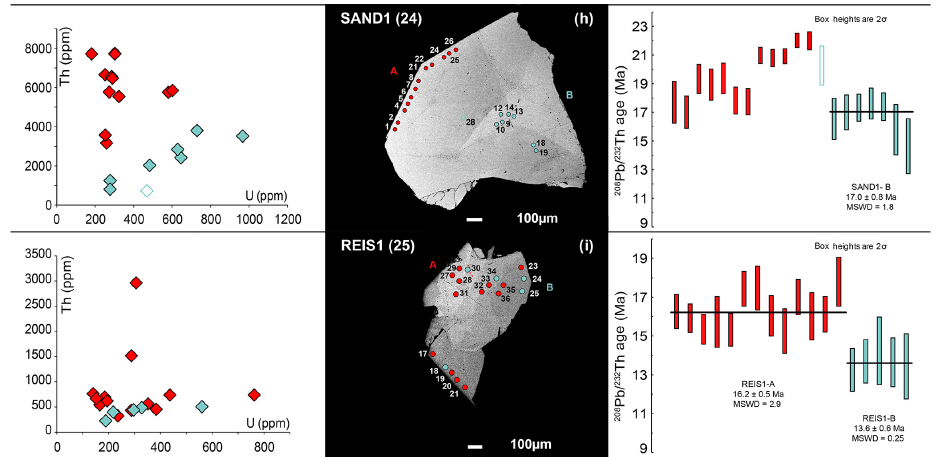
Figure 5. Chemical, textural and geochronological information of monazite grains from the eastern TW. On BSE images, colour-filled circles correspond to ion probe spot locations. Note that the square-shape shading in grains 15, 17, 18 and 20 is due to an artefact of composing BSE images with diverse contrast.